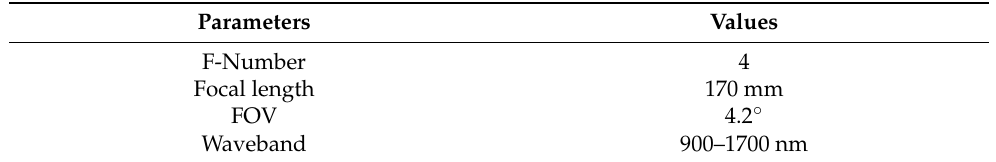
Table 1. Optical specifications of the fore-optics.